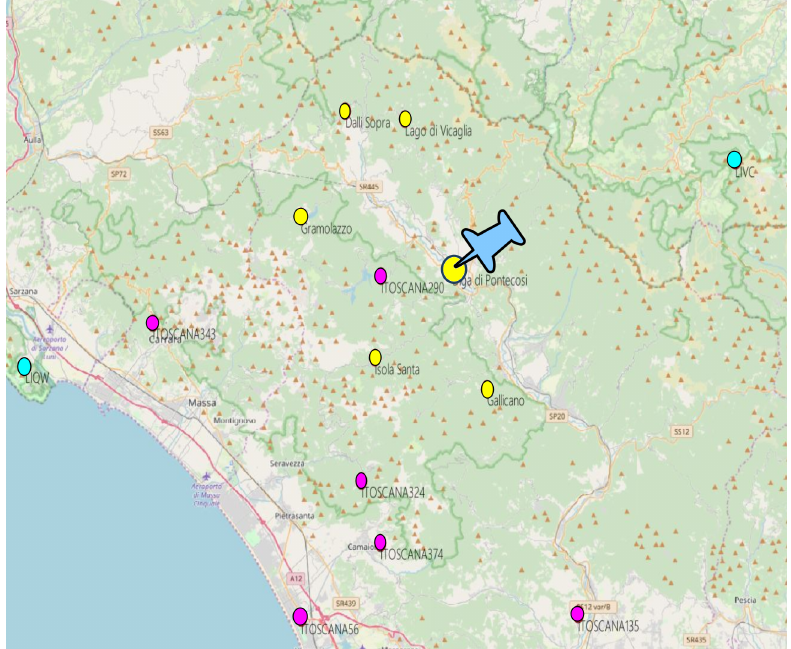
Figure 4. Weather stations positions. Yellow points are the plant owner stations, magenta points are Wunderground stations, and cyan points are Aeronautica Militare stations.